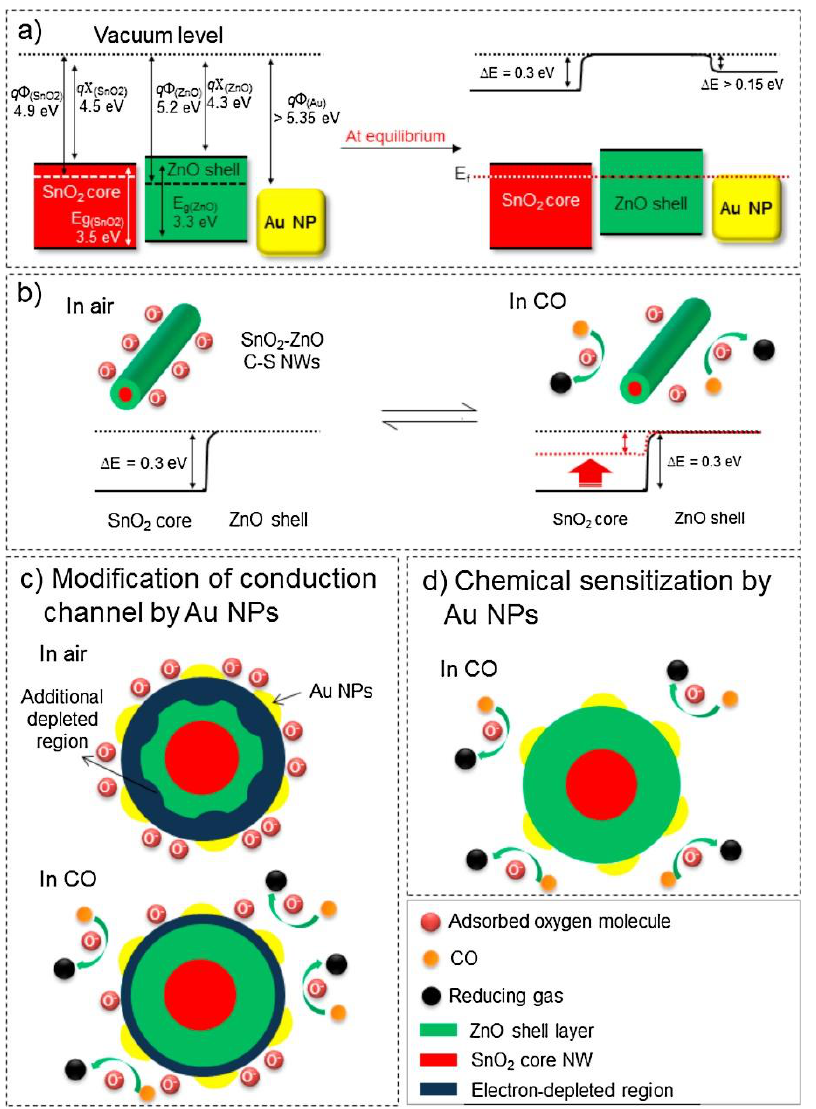
Figure 7. ( a ) Energy levels of SnO 2 – ZnO and Au in vacuum and air after contact. ( b ) Modulation of SnO 2 – ZnO heterojunctions in the presence of CO gas. ( c ) Modification of an EDL inside ZnO by Au. ( d ) Chemical sensitization of Au. Reprinted with permission from Ref. [67]. Copyright 2017, Elsevier.